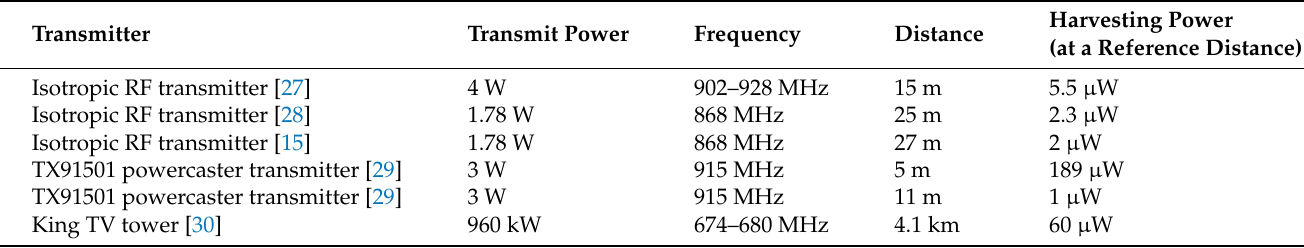
Table 2. Experimental evaluations for RF power